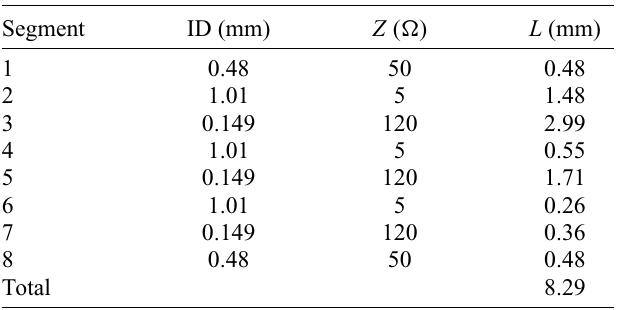
TABLE I. Parameters of the stepped-impedance filter (ID, inner conductor diameter; Z , impedance; L , length). Segment 1 is the innermost